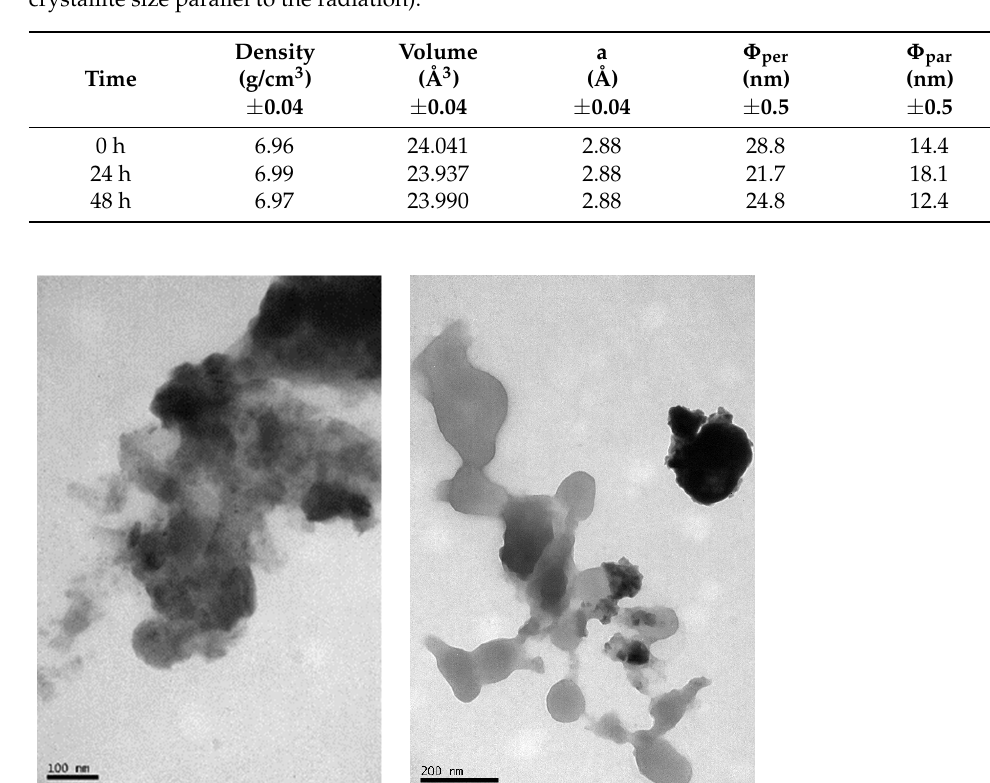
Figure 2. Transmission electron microscopy (TEM) images of the Fe 90 Al 10 system with 48 h of mechanical alloying with surfactant.